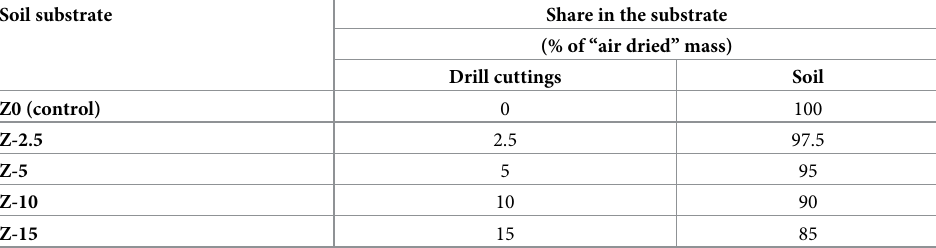
Table 2. Composition of the soil substrates used in the pot experiment. Soil